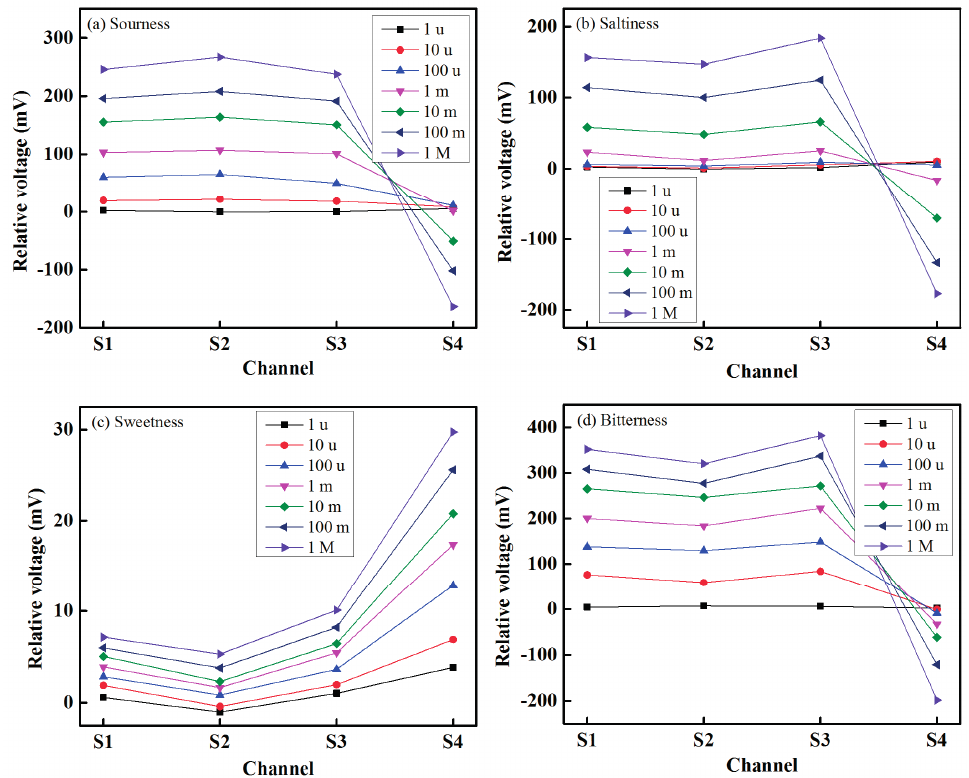
Figure 12. Taste sensing responses of the proposed IDC taste sensing elements of the array under different samples with different levels of concentration: ( a ) sourness; ( b ) saltiness; ( c ) sweetness; and ( d )